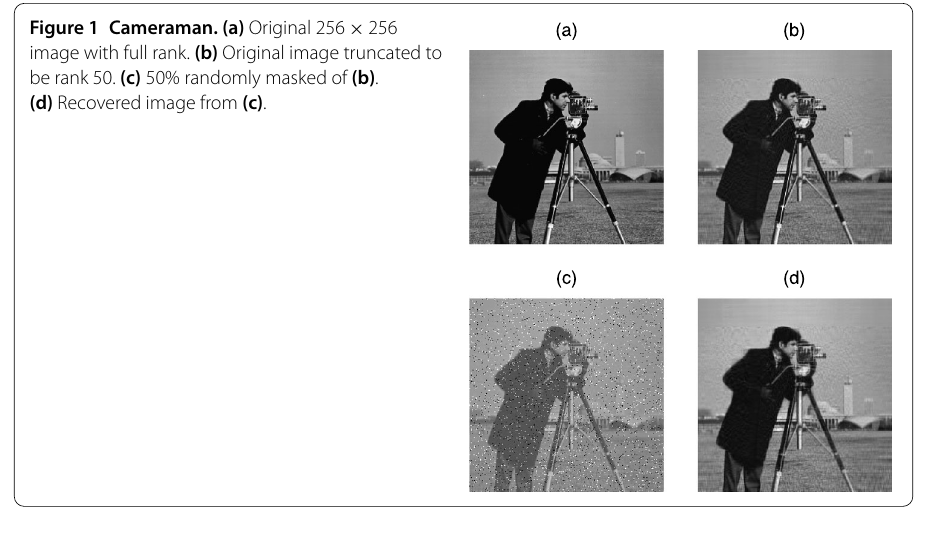
Figure 2 Barbara. (a) Original 512 × 512 image with full rank. (b) Original image truncated to be rank 100. (c) 50% randomly masked of (b) . (d) Recovered image from (c) .